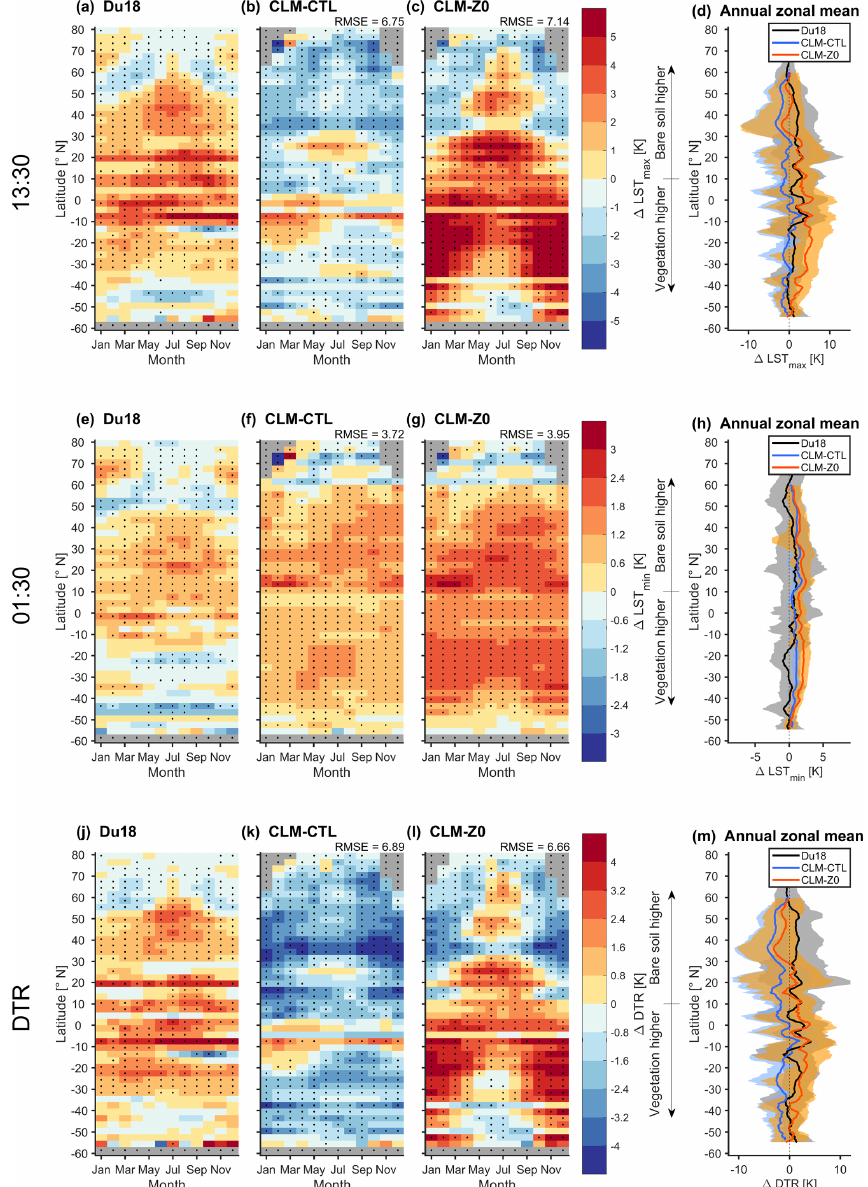
Figure 9. LST sensitivity in Du18 and CLM to conversion of vegetation to bare land. (a–d) LST difference between bare soil minus vegetated land at 13:30 local solar time ( (cid:49) LST max ). Seasonal and latitudinal variations of ( (cid:49) LST max ) in (a) the observation-based estimate of Du18, (b) CLM-CTL, and (c) CLM-Z0. Points with a mean which is significantly different from 0 in a two-sided t test at the 95% confidence level are marked with a black dot. All data from the 2008–2012 analysis period corresponding to a given latitude and a given month are pooled to derive the sample set for the test. The numbers next to the titles are the area-weighted spatiotemporal root-mean-squared deviation of the respective simulation against Du18. Panel (d) shows the zonal annual mean of Du18 (black, range between the 10th and 90th percentiles in gray), CLM-CTL (blue, range between the 10th and 90th percentiles in blue), and CLM-Z0 (red, range between the 10th and 90th percentiles in orange). Note that on this subfigure results have been smoothed latitudinally with a simple moving average over 4 ◦ . CLM data are cloud masked based on the incoming shortwave radiation. Panels (e–h) are the same for the LST difference at 01:30 local solar time and panels (j– m) for the diurnal temperature